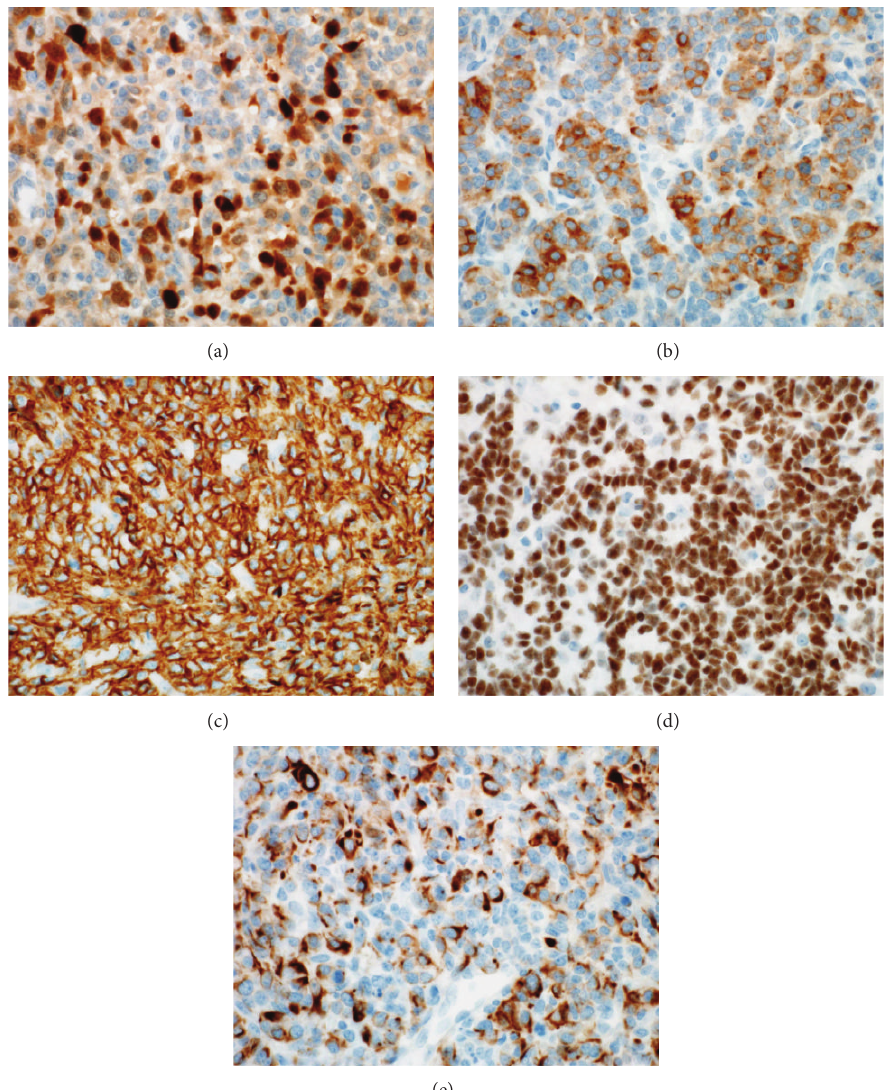
Figure 4: Immunohistochemical examination of the left ovarian mass. (a) The neoplastic cells stained positive for calretinin (magnification power: 40x). (b) The neoplastic cells stained positive for inhibin (magnification power: 40x). (c) The neoplastic cells stained positive for CD56 (magnification power: 40x). (d) The neoplastic cells stained positive for WT-1 (magnification power: 40x). (e) The neoplastic cells stained positive for CK 8/18 (magnification power: